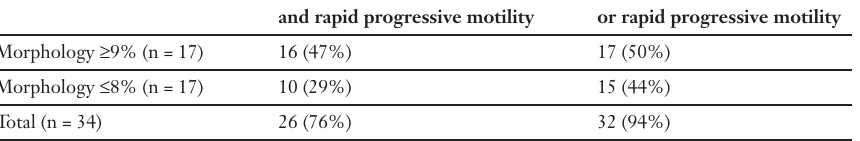
Number of fertile men who reach nor- mal criteria (concen- tration and/or rapid progressive motility) (n =